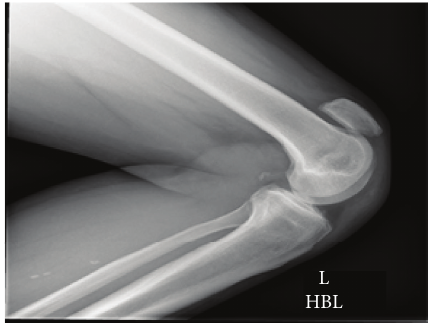
Figure 2: Lateral radiograph of left knee.